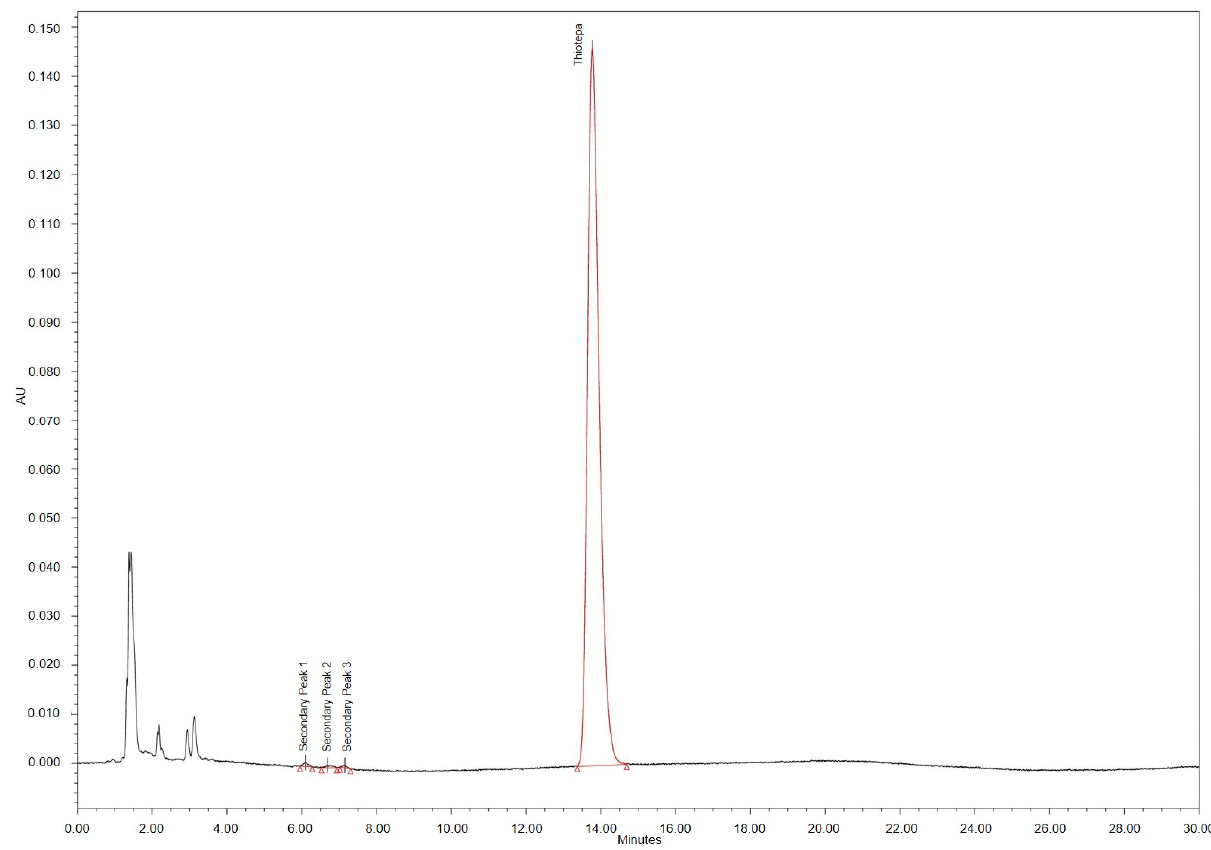
Figure 4. HPLC chromatogram of thiotepa 1 mg/mL infusion diluted with G5 infusion solution and stored at 25 °C for 14 days.